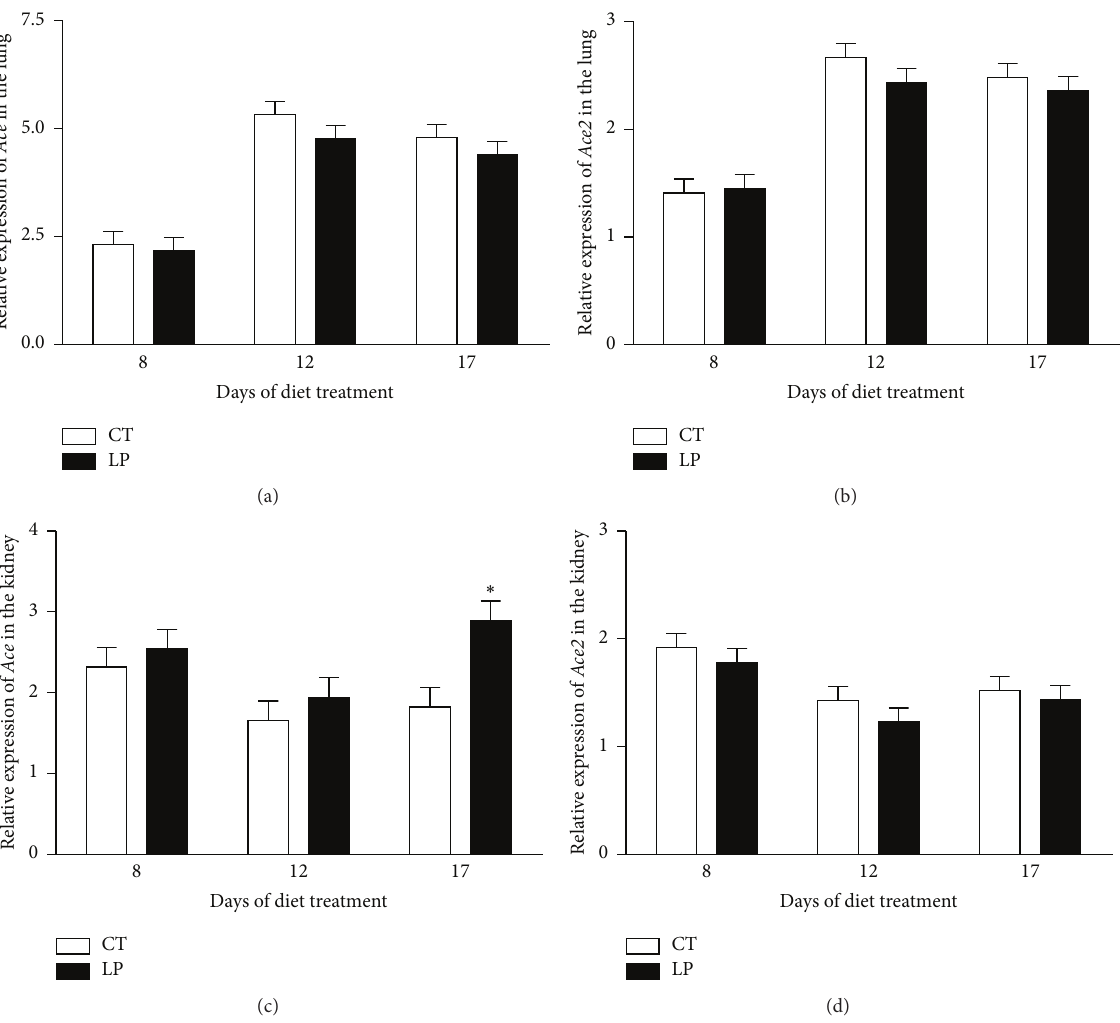
Figure 2: Quantitative real-time PCR analysis of Ace and Ace2 in the lung ((a), (c)) and kidney ((b), (d)) of nonpregnant rats fed a low-protein diet. CT: control; LP: low protein. The error bar represents the mean ± SEM expressed as relative units of mRNA standardized against R18s ( 𝑛 = 6 rats/diet group/day). ∗ 𝑃 < 0.05